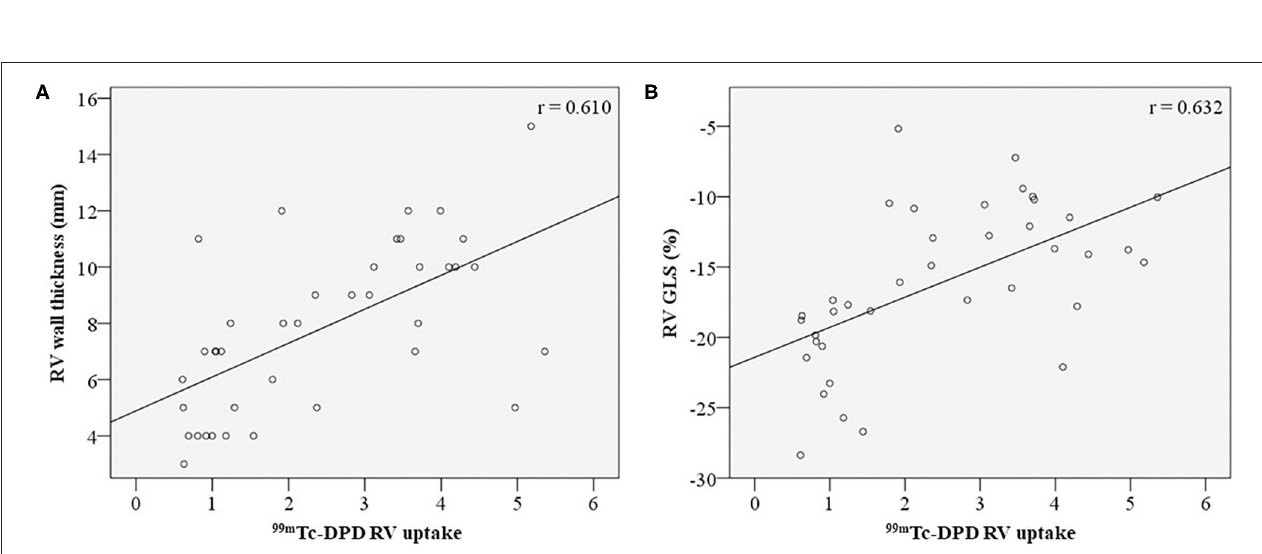
FIGURE 4 | Correlation of RV structural and functional parameters with 99m Tc-DPD uptake. 99m Tc-DPD RV uptake correlation with RV wall thickness (A) and RV GLS (B) . 99m Tc-DPD, Technetium-99m 3,3-diphosphono-1,2-propanodicarboxylic acid; RV, Right ventricle; GLS, global longitudinal